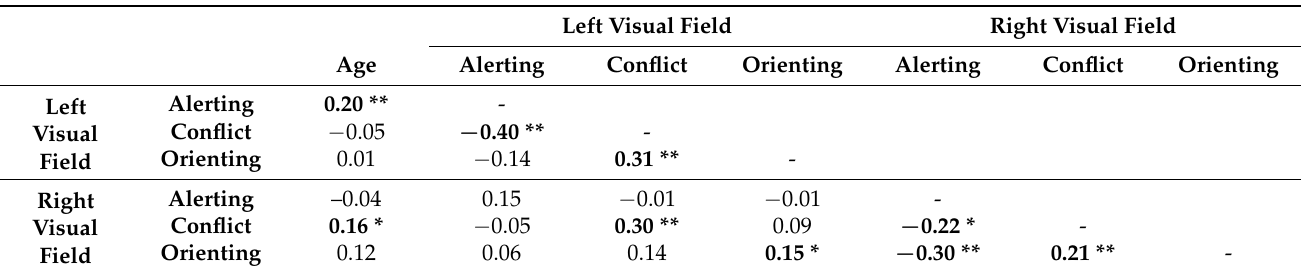
Table 3. Partial correlations between age and the three attentional effects for the LVF and RVF (confounding variables: years of education; MMSE; IQ).